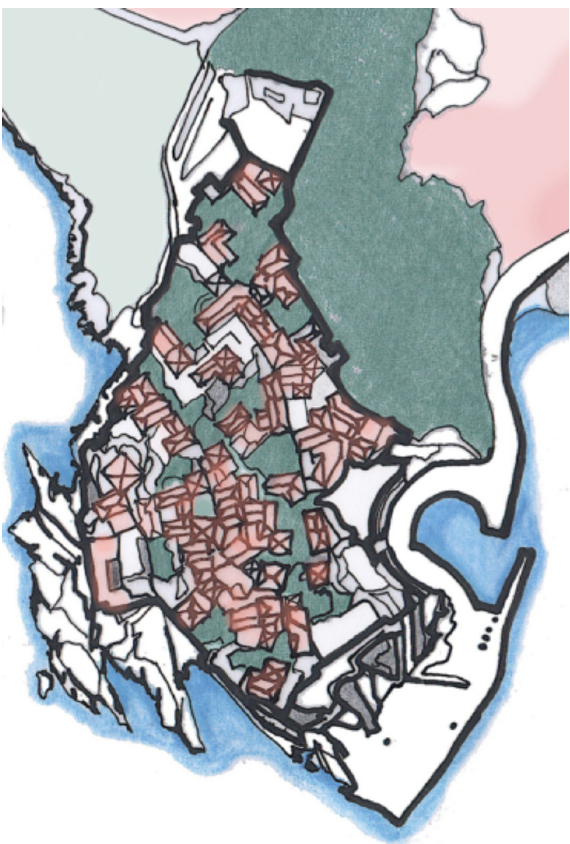
Fig. 1. Urban development of the Ulcinj Riviera, the city castle and urban morphology.